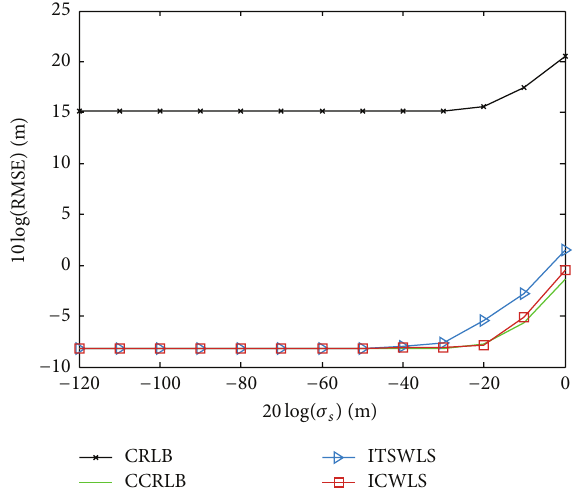
Figure 4: Comparison of target geolocation RMSEs of ITSWLS and ICWLS as a function of 𝜎 𝑠 .